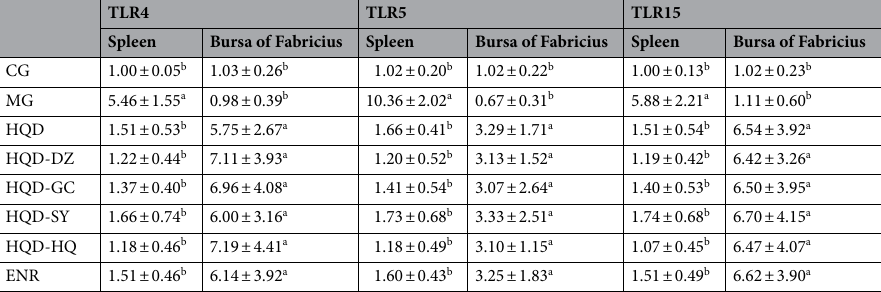
Table 3. The mRNA level of Toll-like receptor (TLR) in spleen and bursa of Fabricius of chicks were shown in the table. The different letter superscript in the same column indicates that the difference is significant ( p < 0.05). CG, Control group; MG, Model group; DZ, Jujube, Jujubae Fructus ; HQ, Scutellaria baicalensis, Scutellariae Radix ; GC, liquorice, Licoric e; SY, Herbaceous peony, Paeoniae Radix Alba ; HQD, decoction consists of DZ, HQ, GC and SY; HQD-DZ, HQD absent of DZ; HQD-GC, HQD absent of GC; HQD-SY, HQD absent of SY; HQD-HQ, HQD absent of HQ; ENR, Enrofloxacin group. (The dosage of Chinese medicine was 500